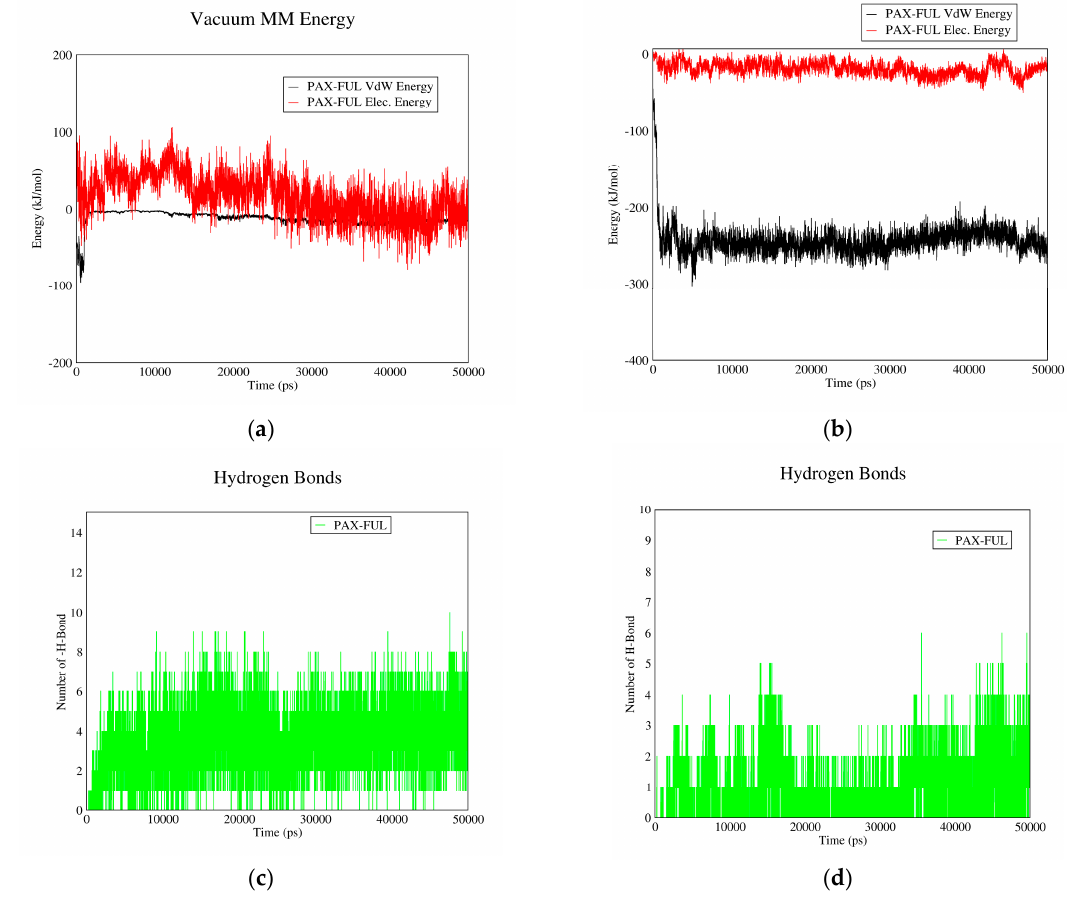
Figure 5. PAX–Fullerene interaction energies and hydrogen bonds: ( a ) electrostatic and Van der Waals energies of PAX–Fullerene interaction versus time in neutral pH; ( b ) electrostatic and Van der Waals energies of PAX–Fullerene interaction versus time in acidic pH; ( c ) the number of hydrogen bonds between PAX and fullerene versus time in neutral pH; ( d ) the number of hydrogen bonds between PAX and fullerene versus time in acidic pH.